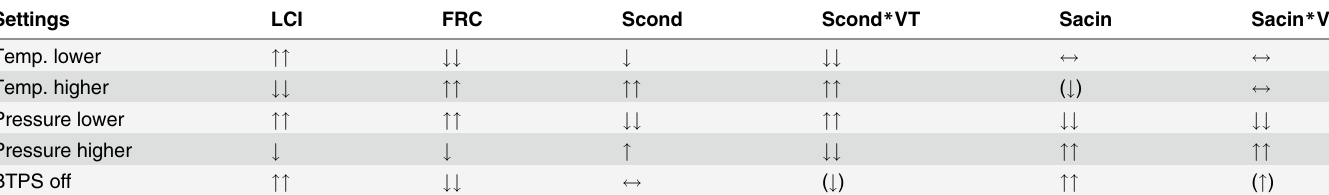
Table 2. Change of N 2 MBW results after reanalysis with different environmental conditions. Settings LCI FRC Scond Scond * VT Sacin Sacin * VT Temp. lower "" ## # ## $ $ Temp. higher ## "" Pressure lower $